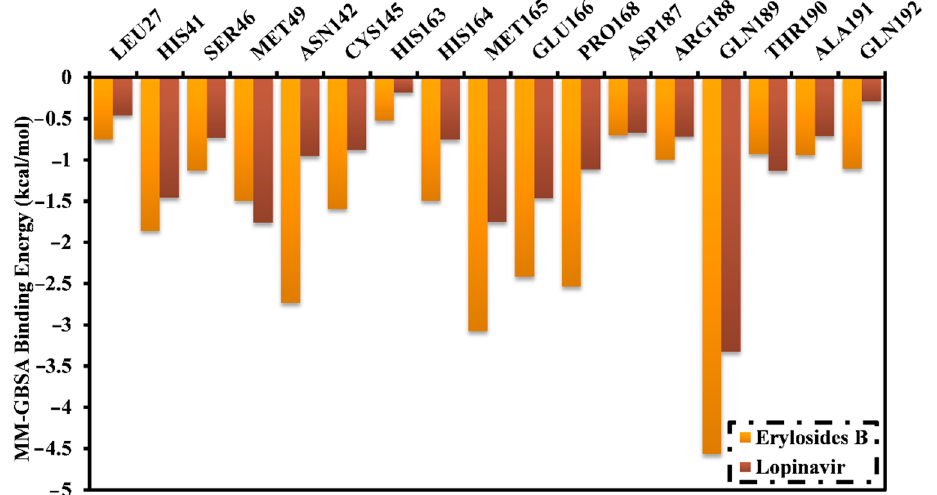
Figure 4. Energy contributions (kcal/mol) for M pro amino acid residues to the binding free energy of erylosides B (226) and lopinavir.